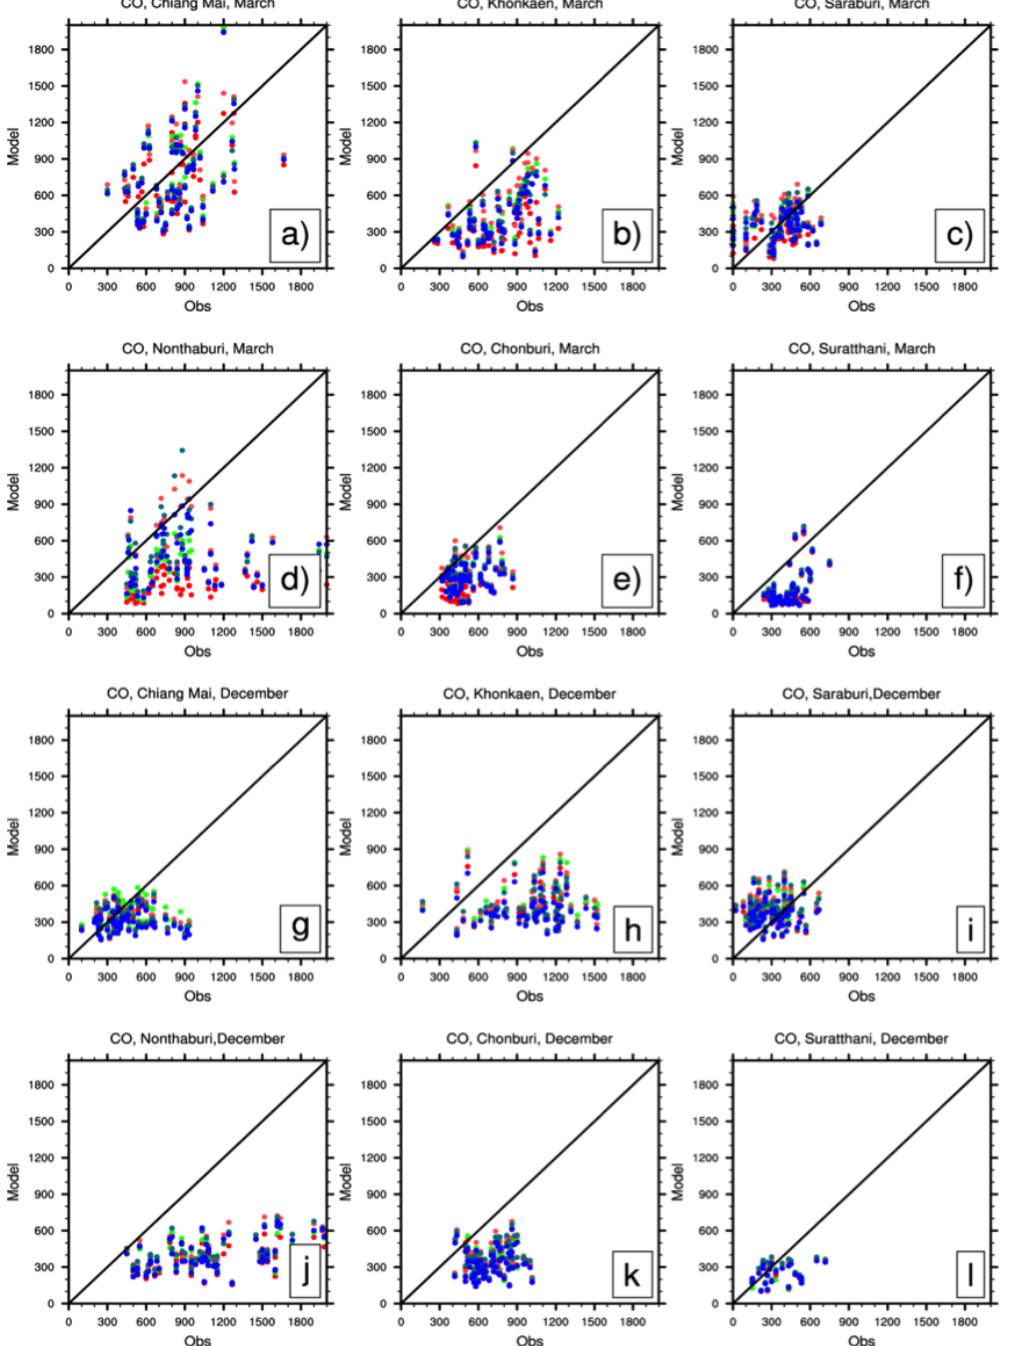
Figure 9. Scatterplots of 6-hourly daytime CO from WRF-Chem using different emissions inventories (red dots are RETRO emissions, teal dots are SEAC4RS, orange dots MACCity, green dots INTEX-B, and blue dots are combined MACCity and SEAC4RS) and ground-based observations for March and